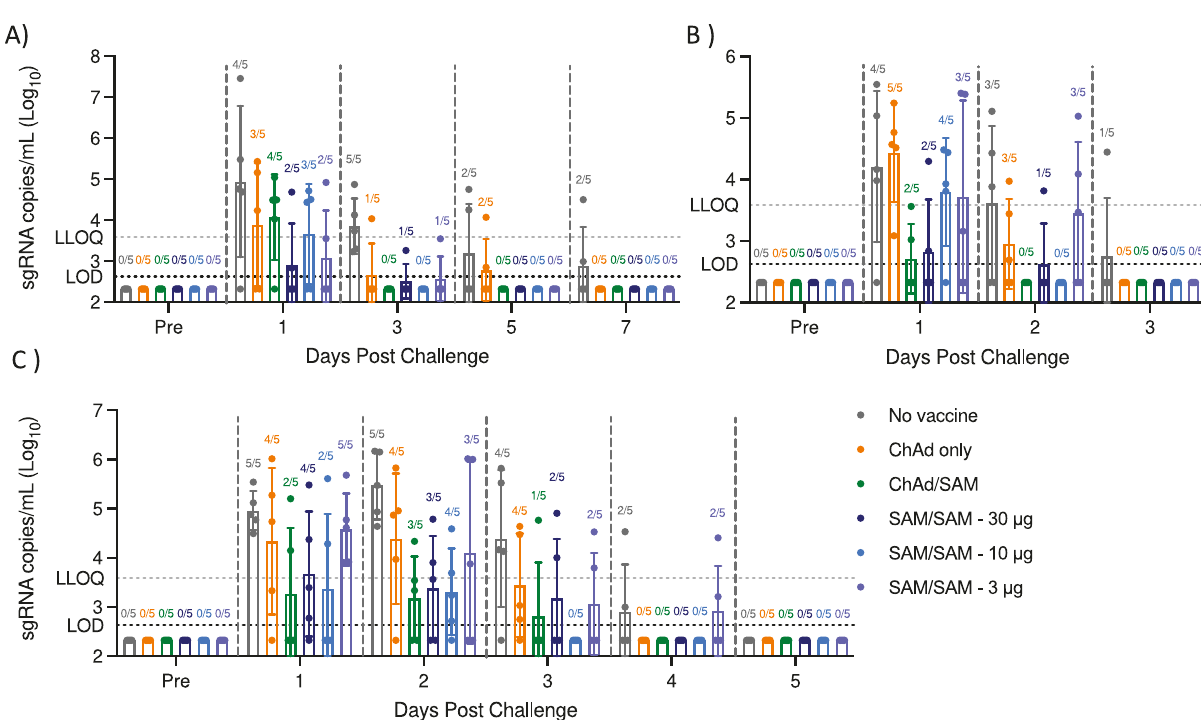
Fig. 4 Viral replication is reduced in all vaccinated NHP following SARS-CoV-2 challenge. Subgenomic RNA levels determined by RT-qPCR at speci fi ed timepoint post SARS-CoV-2 challenge for each animal in A bronchial alveolar lavage, B oropharyngeal swab, or C nasal swab. LOD = 422, samples below LOD set to ½ LOD. Geometric mean and SD. Numbers above each bar are numbers of NHP with viral load levels >LOD. Additional timepoints post complete clearance of viral RNA from vaccinated animals are not shown for clarity, full dataset provided in Supplementary